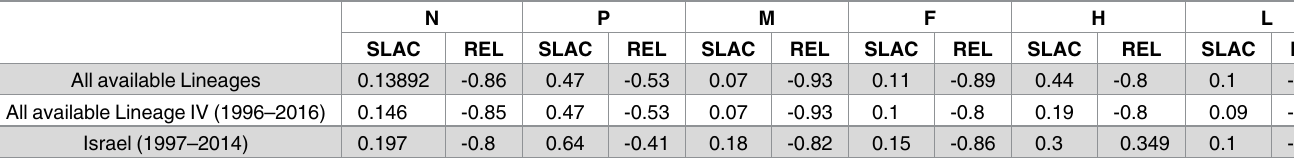
Table 3. Mean dN/dS values for PPRV coding regions following analysis for positive selection. N P M